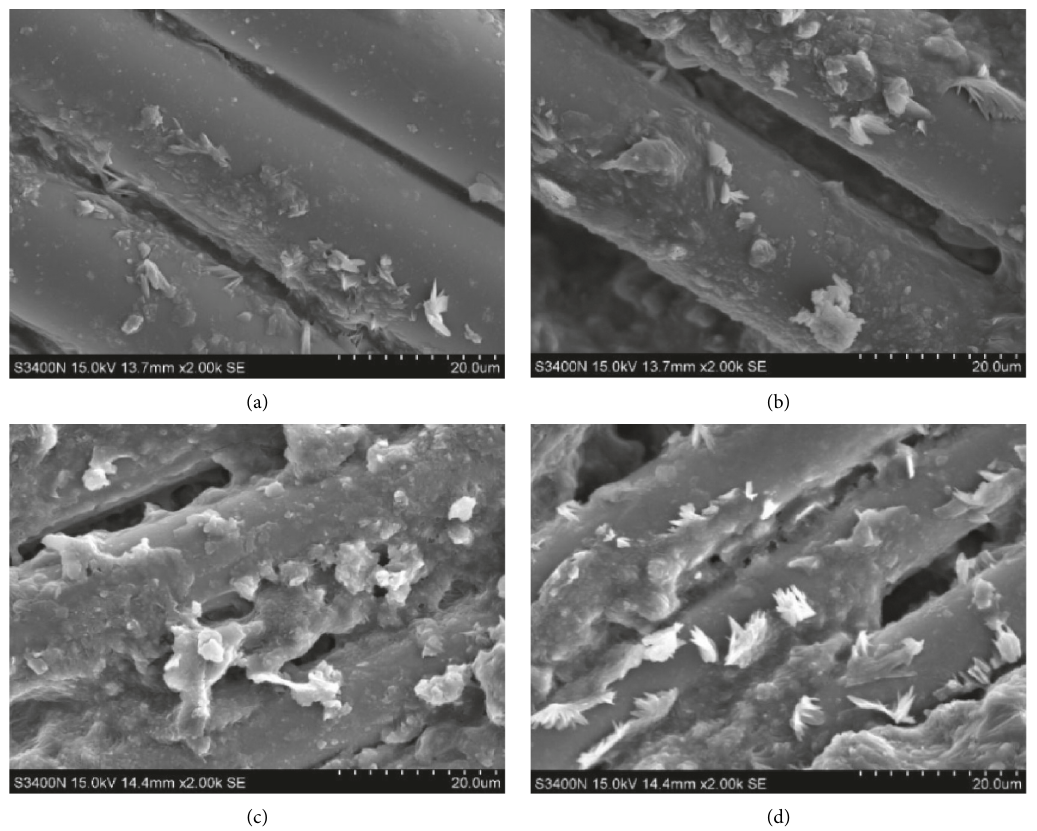
Figure 12: SEM of Group F and Group G magnification: 2000. (a) F1. (b) F2. (c) G1. (d)